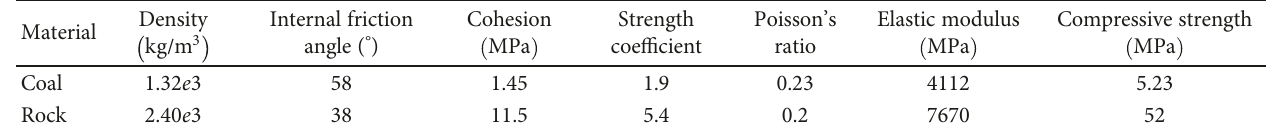
Table 2: The material parameters of coal and the dirt band.